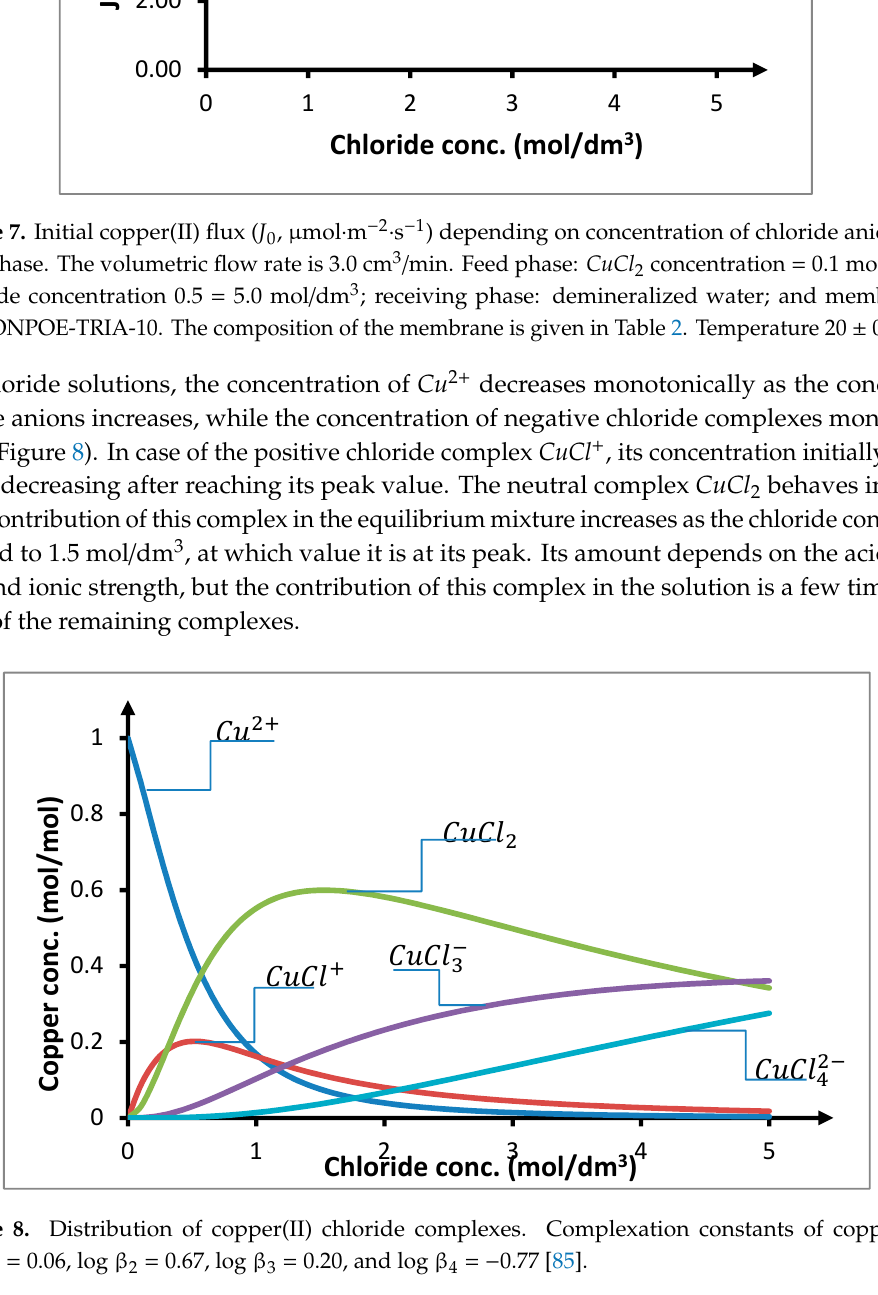
Figure 7. Initial copper(II) flux (J 0 , μ mol ∙ m − 2 ∙ s − 1 ) depending on concentration of chloride anions in feed phase. The volumetric flow rate is 3.0 cm 3 /min. Feed phase: CuCl 2 concentration = 0.1 mol/dm 3 , chloride concentration 0.5 = 5.0 mol/dm 3 ; receiving phase: demineralized water; and membrane: CTA-ONPOE-TRIA-10. The composition of the membrane is given in Table 2. Temperature 20 ± 0.5 °C.